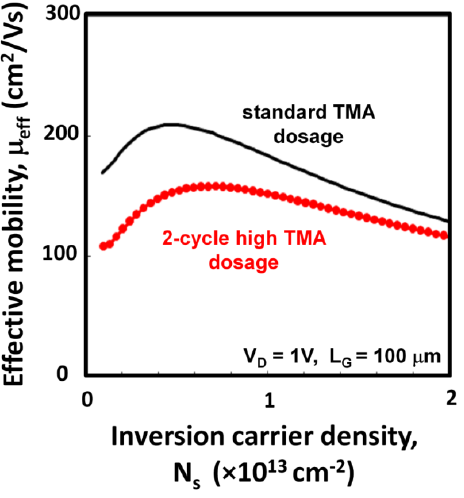
Figure 7. Effective mobilities µ dosage devices. Split C-V data at 1 kHz of the long-channel devices (L were used to estimate the inversion carrier density N